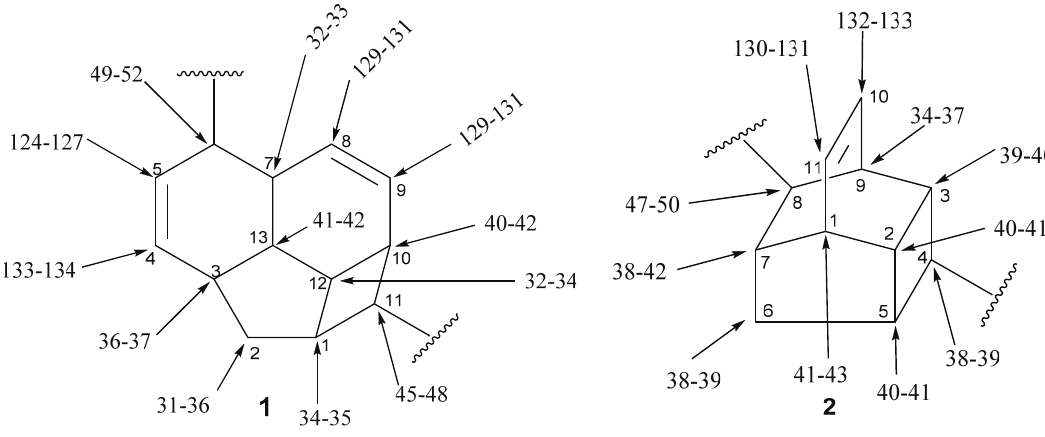
Figure 2. Range of 13 C NMR chemical shift of the tetracyclic endiandric acid (skeleton 1 and 2